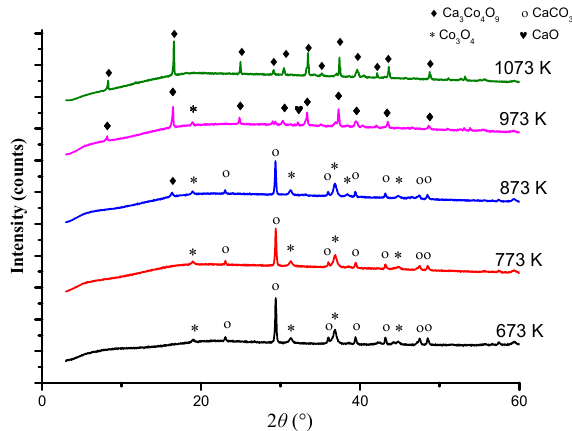
Fig. 4 XRD patterns of black powder before calcination and after calcinated for 4 h at 773, 873, 973, and 1073 K.